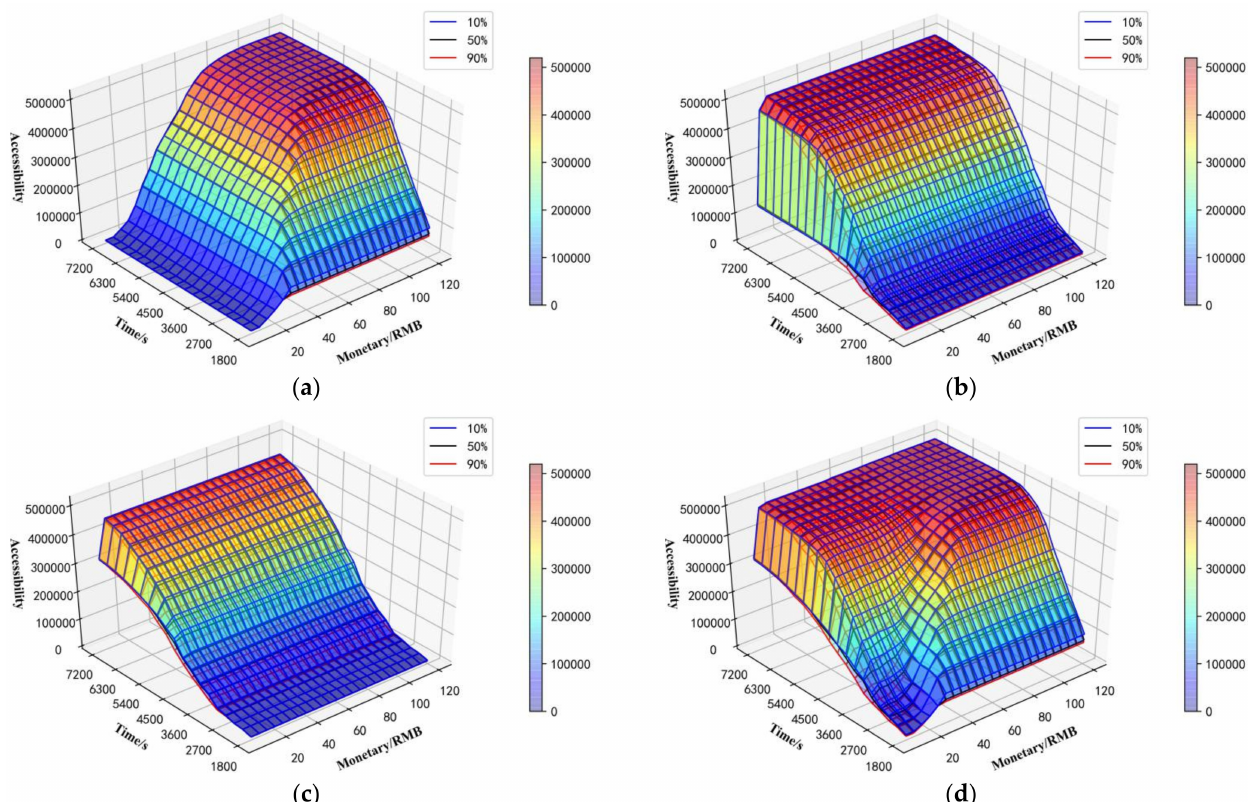
Figure 12. The impact of reliability on accessibility: ( a ) taxi, ( b ) bus, ( c ) subway, and ( d )